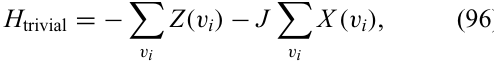
FIG. 3. (a) A 2D example that demonstrates how nonultralo- cal flux terms may occur even with constraint terms that are ultralocal at 0 strata. The bold lines are the coarser lattice. The plaquettes of the coarser lattice are 2 strata, edges are 1 strata, and vertices are 0 strata. The light gray lines form the finer lattice. The defect network for the Ising model in Eq. (95) is depicted on the left. Its matter qubits live on the vertices of the finer lattice. It has ultralocal constraint terms at each vertex. Four such terms indicated on the left, along with ZZ terms in the 2 strata, generate a relation that is not ultralocal. After gauging this leads to a flux term that is not ultralocal, depicted on the right. (b) A demonstra- tion of why the naive TDN for the cubic code is not ultralocal, similar to the example shown above in (a). While the constraint terms of the ungauged model (left) are ultralocal, the relations involving them are not. After gauging, this leads to a flux term in the cubic code TDN that is not ultralocal, shown on the right. We find that an additional coarse-graining step along each axis is sufficient to construct an ultralocal TDN, as explained in the main